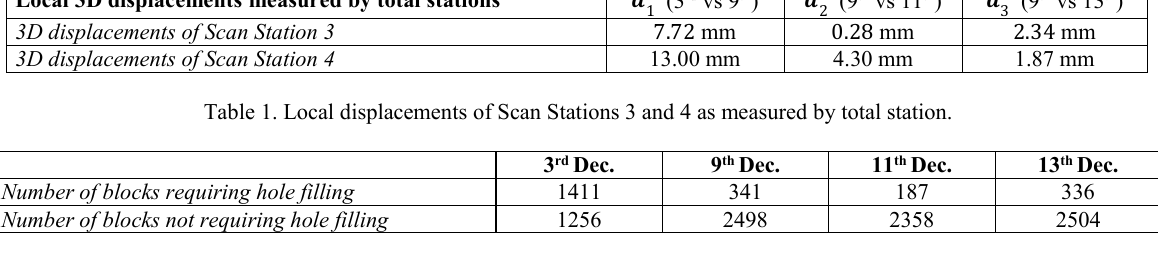
Table 2. Number of blocks that required or did not require the Hole-Filling algorithm. RMS of std. devs. of representative points